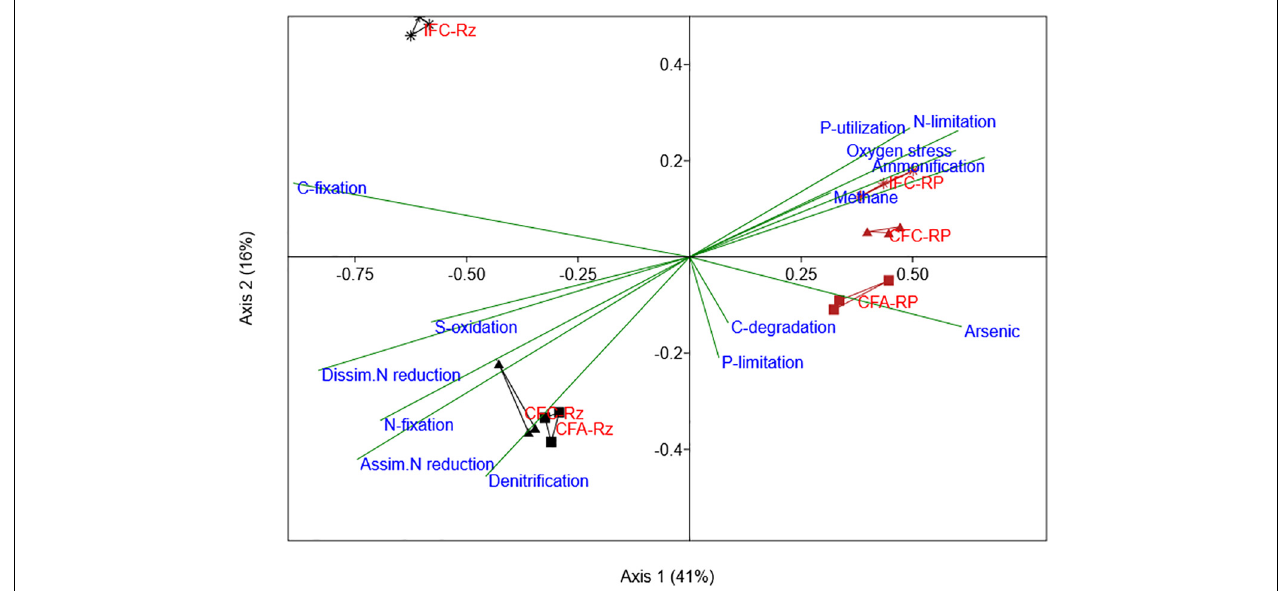
FIGURE 5 | Canonical correspondence analysis for SRB (dsrA/B, APS_AprA/B gene probes) abundances compared with other functional associations in their genomes (other gene category probes detected in these organisms). The SRB gene probes positive organisms from each sample were selected from other gene categories and their abundance was summed by samples. This data was used as variables for correspondence analysis and then were plotted according to their correlations with SRB gene probes.